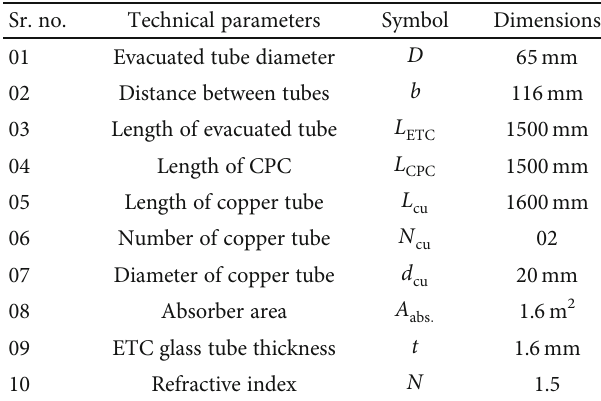
Figure 3: CPC with aluminum foil and Mylar. Table 1: Technical parameters and dimensions for a desalination